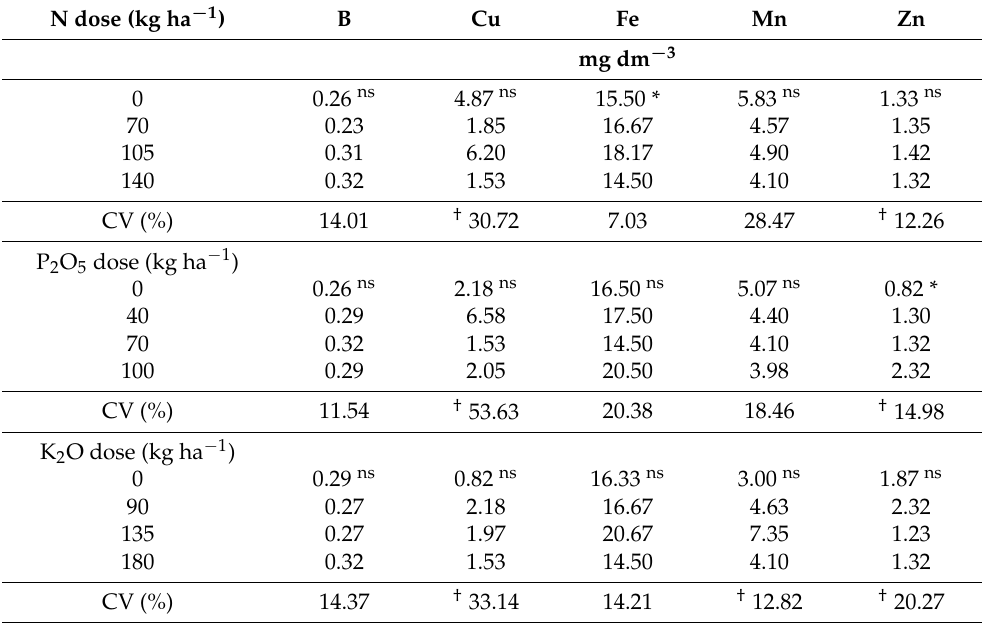
Table 2. Mean soil micronutrient contents at a depth of 0–20 cm at seventy-six months after eucalyptus plantation as a function of N, P 2 O 5 , and K 2 O fertilization rates.